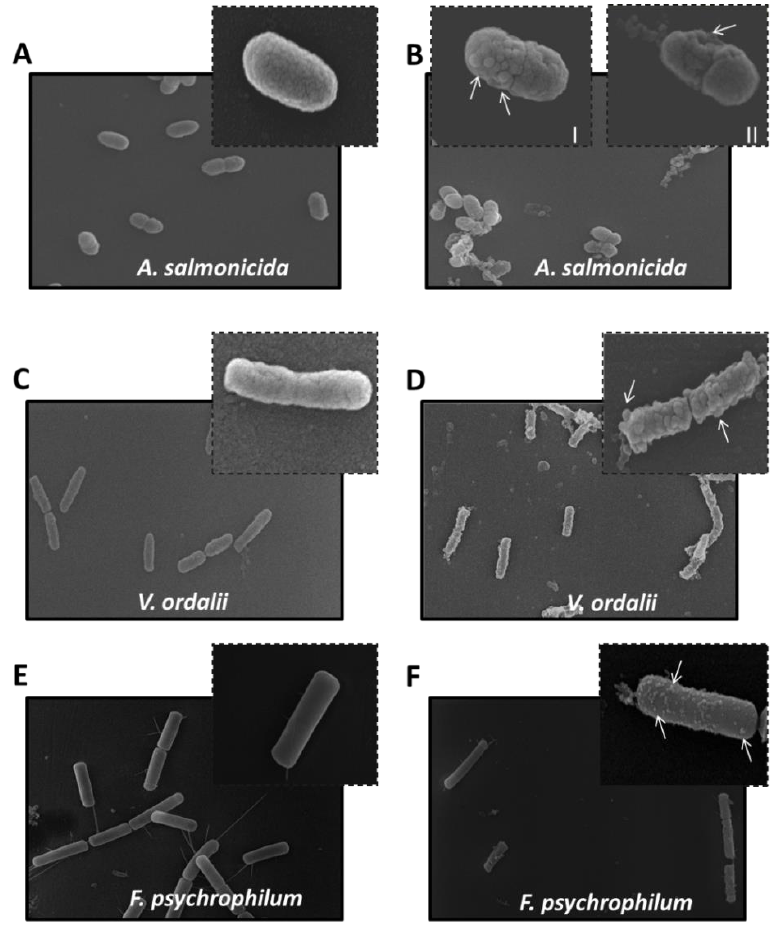
Figure 5. Bacterial membrane disruption induced for the synthetic cyclotide. ( A ) SEM micrographs of A. salmonicida subsp. salmonicida without peptide. Segmented quadrant shows a zoom of representative bacteria. ( B ) SEM micrographs of A. salmonicida subsp. salmonicida in the presence of 22.5 μM of synthetic cyclotide. Segmented quadrant (I) shows a zoom of representative bacteria, indicating blisters on the surface with arrows. Additionally, a bacterium with partial outer membrane detachment is shown (II). ( C ) SEM micrographs of V. ordalii without peptide. Segmented quadrant shows a zoom of representative bacteria. ( D ) SEM micrographs of V. ordalii in the presence of 30 μM of synthetic cyclotide. Segmented quadrant shows a zoom of representative bacteria indicating blisters on the surface with arrows. ( E ) SEM micrographs of F. psychrophilum cells without peptide. Segmented quadrant shows a zoom of representative bacteria. ( F ) SEM micrographs of F. psychrophilum cells in the presence of 12.5 μM of synthetic cyclotide. Segmented quadrant shows a zoom of representative bacteria indicating blisters on the surface with arrows.